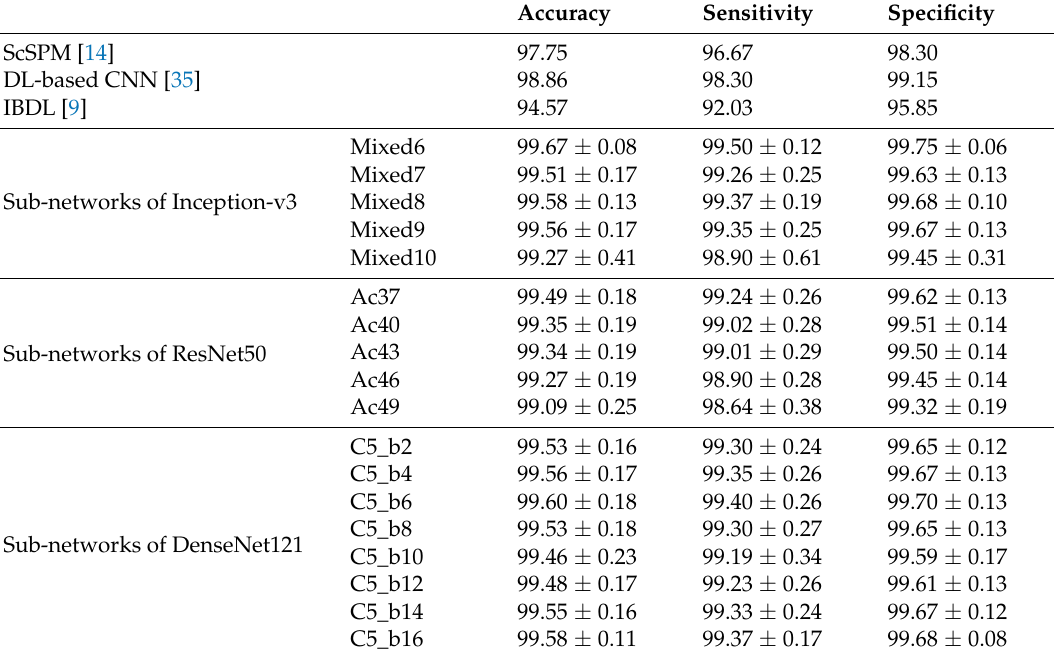
Table 5. The performance (%) of the sub-networks on the clinical dataset.